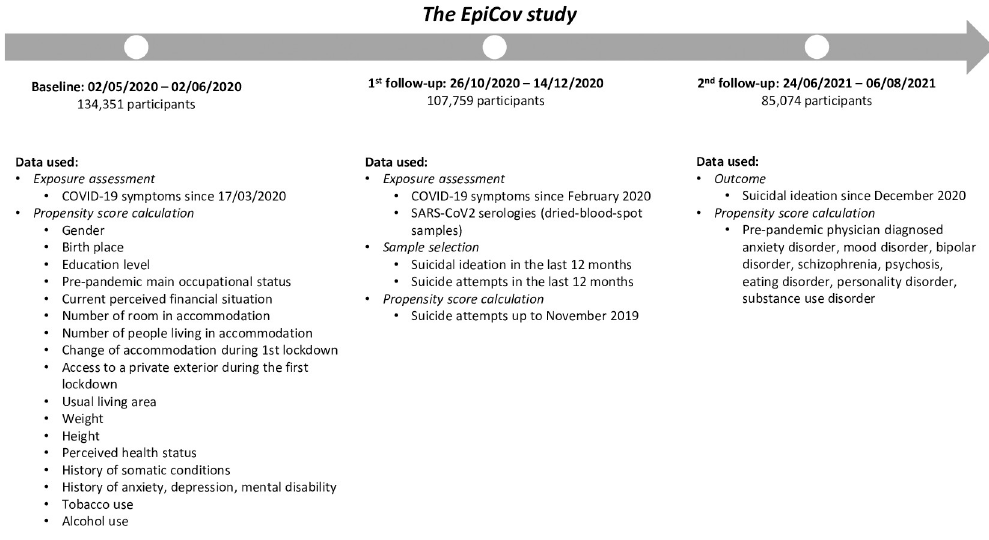
Fig 1. The EpiCov study timeline and data